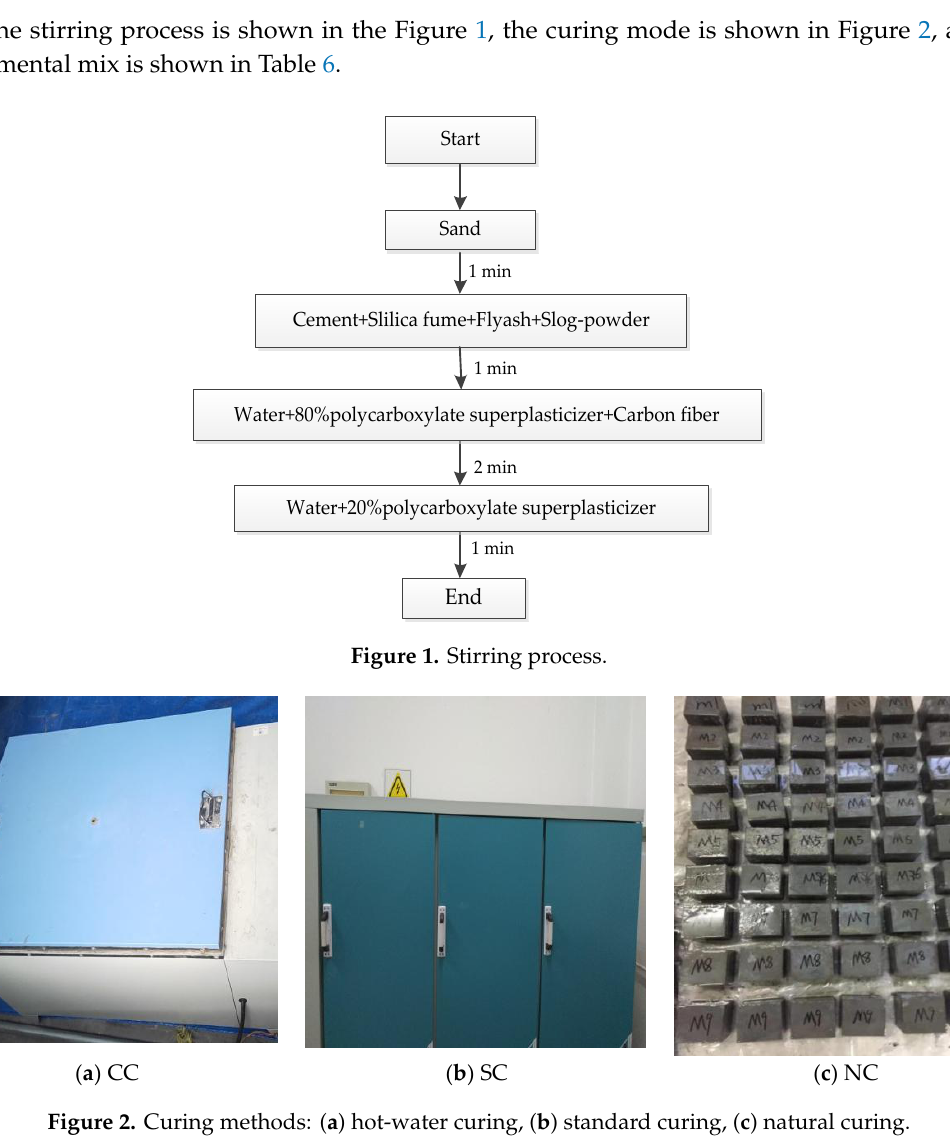
Figure 2. Curing methods: ( a ) hot-water curing, ( b ) standard curing, ( c ) natural curing. Table 6. Mix proportions of carbon-fiber reactive powder concrete (RPC).